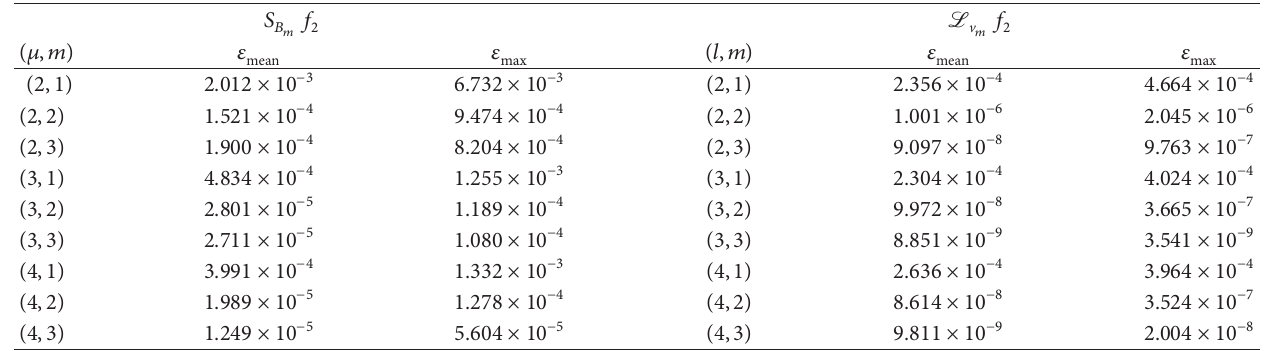
and L V for the sphere 𝑚 𝑚